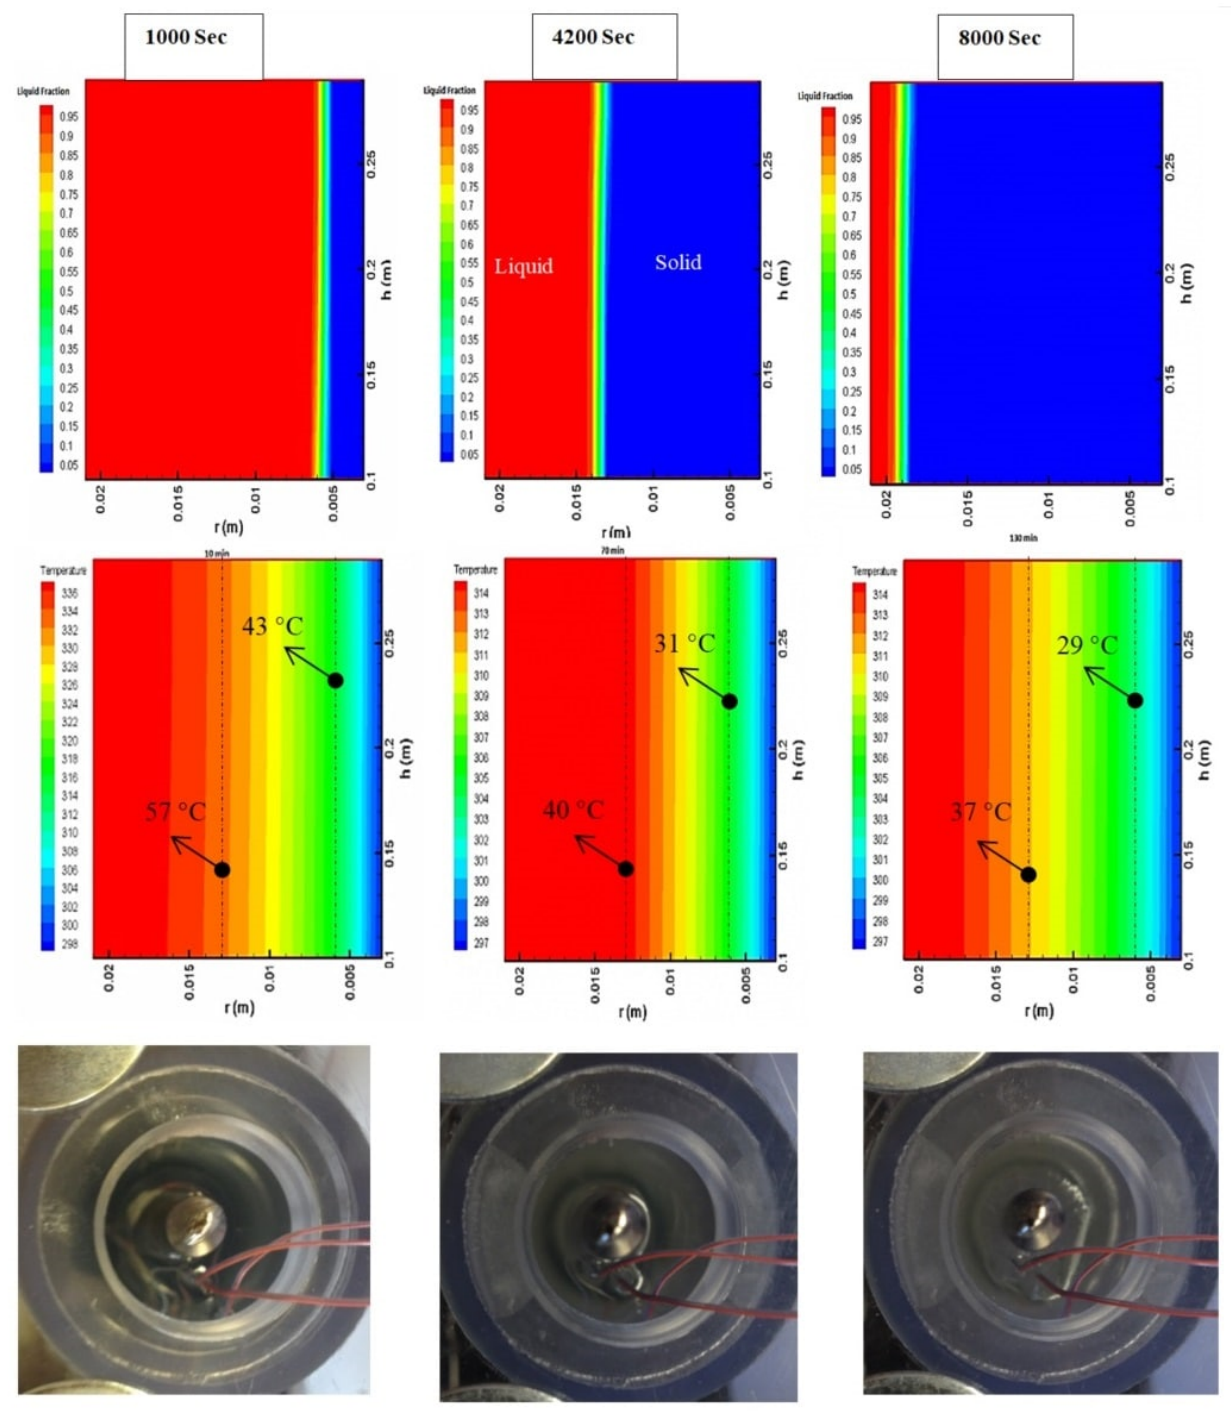
Figure 15. The PCM solidification, the simulation results of the temperature evolution, and liquid fraction of the PCM at a 23 °C discharge process.